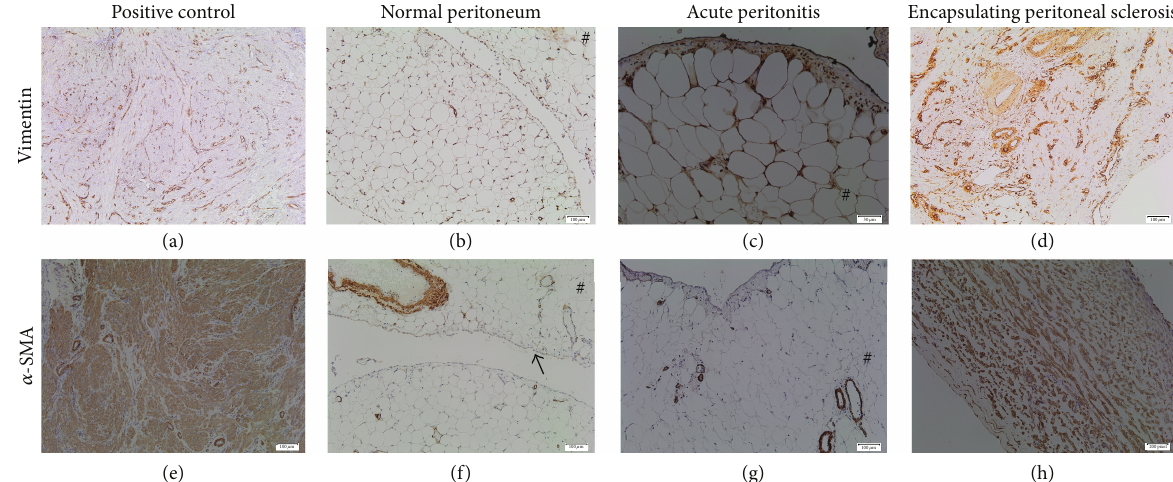
Figure 5: Representative photomicrographs demonstrating histopathological data of mesenchymal markers expression in parietal peritoneal tissues biopsy using immunostaining of vimentin (a–d) and alpha-smooth muscle actin ( 𝛼 -SMA) (e–h). Positive control of immunostainings for used antibodies (internal controls) (a, e), control: normal peritoneum (b, f), case of acute peritonitis (control 3; c and g), and case 1 of encapsulating peritoneal sclerosis (EPS) (d and h). (a, e) Normal peritoneum, expression of vimentin ( → ) limited to few interstitial cells and of 𝛼 -SMA expression to vascular walls. (c, g) Acute peritonitis: interstitial vimentin+ cells, lack of expression of vimentin in mesothelial cell layer; 𝛼 -SMA found only in the vessels. (d, h) Case of encapsulating peritoneal sclerosis (EPS): absence of expression of both markers in the mesothelial cell layer. Note diffuse accumulation of vimentin+ cells identifying interstitial mesenchymal cells and 𝛼 -SMA immunostaining of numerousinterstitialcellsentrappedinthefibroticareasreflectingthepresenceofmyofibroblasts.Immunoperoxidasestainingcounterstained with haematoxylin. Original magnification: (a–g) × 20. (h) × 4.